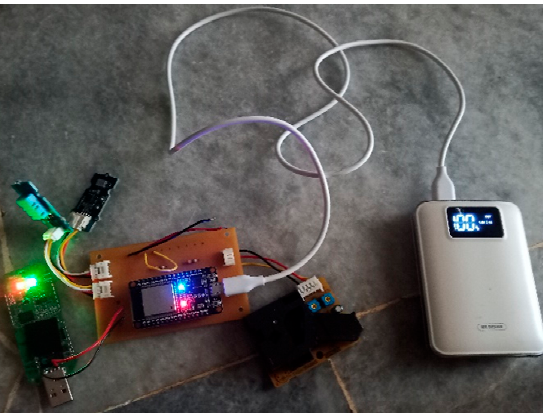
Figure 8. Connectivity of the individual outdoor exposure indicator using wireless system.